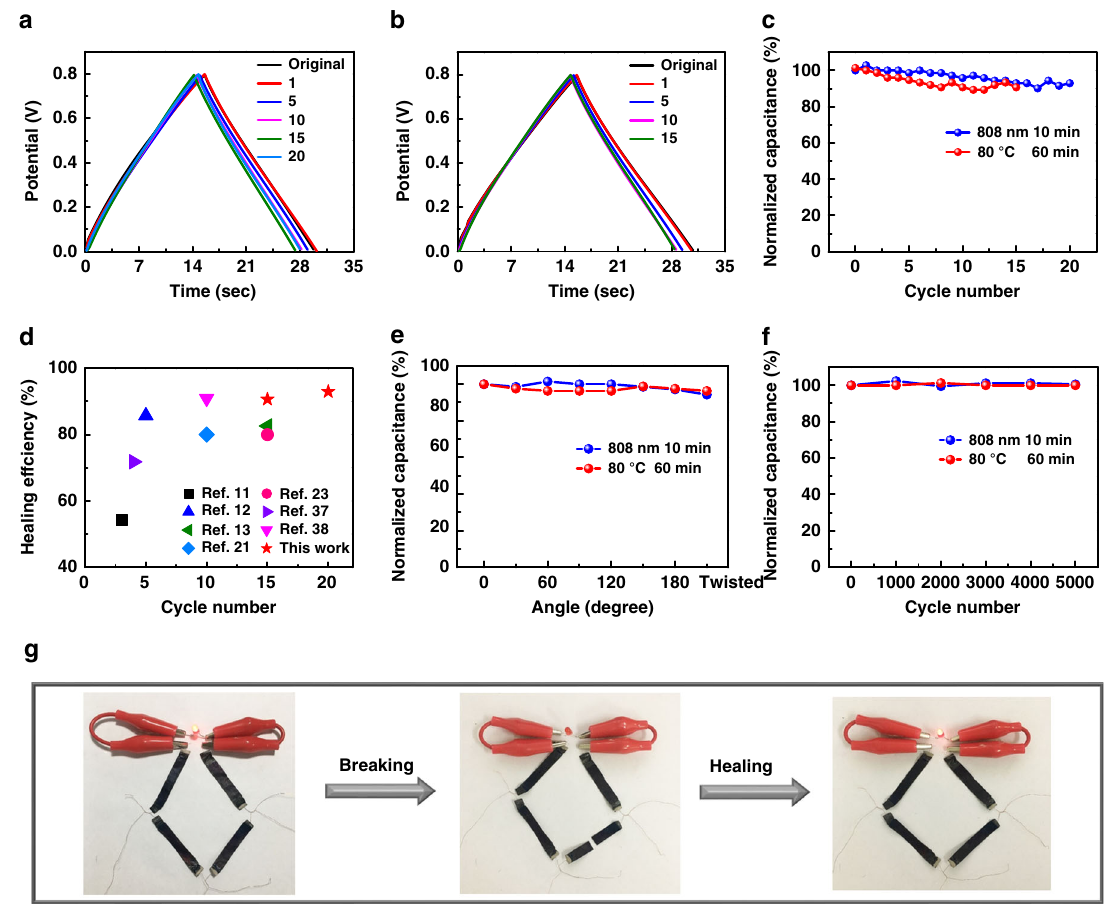
Fig. 3 Healing performance of supercapacitors based on hydrogel electrolyte. a , b Galvanostatic charge/discharge (GCD) curves of supercapacitor devices healed by irradiation with 808 nm infrared light for 10 min ( a ) and heating at 80 o C for 60 min ( b ) for different broken/healed cycles. The numbers 1, 5, 10, 15, and 20 correspond to the number of cycles. c Speci fi c capacitance retention of supercapacitor devices by broken/healed for various cycles. d Comparison of the healing ef fi ciency and cycling number of our supercapacitors with previously reported results. e , f Speci fi c capacitance retention of a healed supercapacitor under different bending angles ( e ) and after 5000 bending cycles to an angle of 120° ( f ). g Digital photographs of four supercapacitors connected in series to power a light-emitting diode (LED) with one device being performed for cut/healed